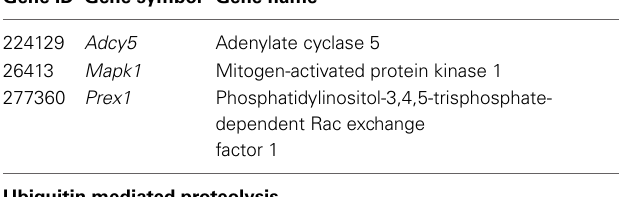
Table 4 | KEGG pathways enriched amongst differentially expressed up or down regulated genes at 80 days old